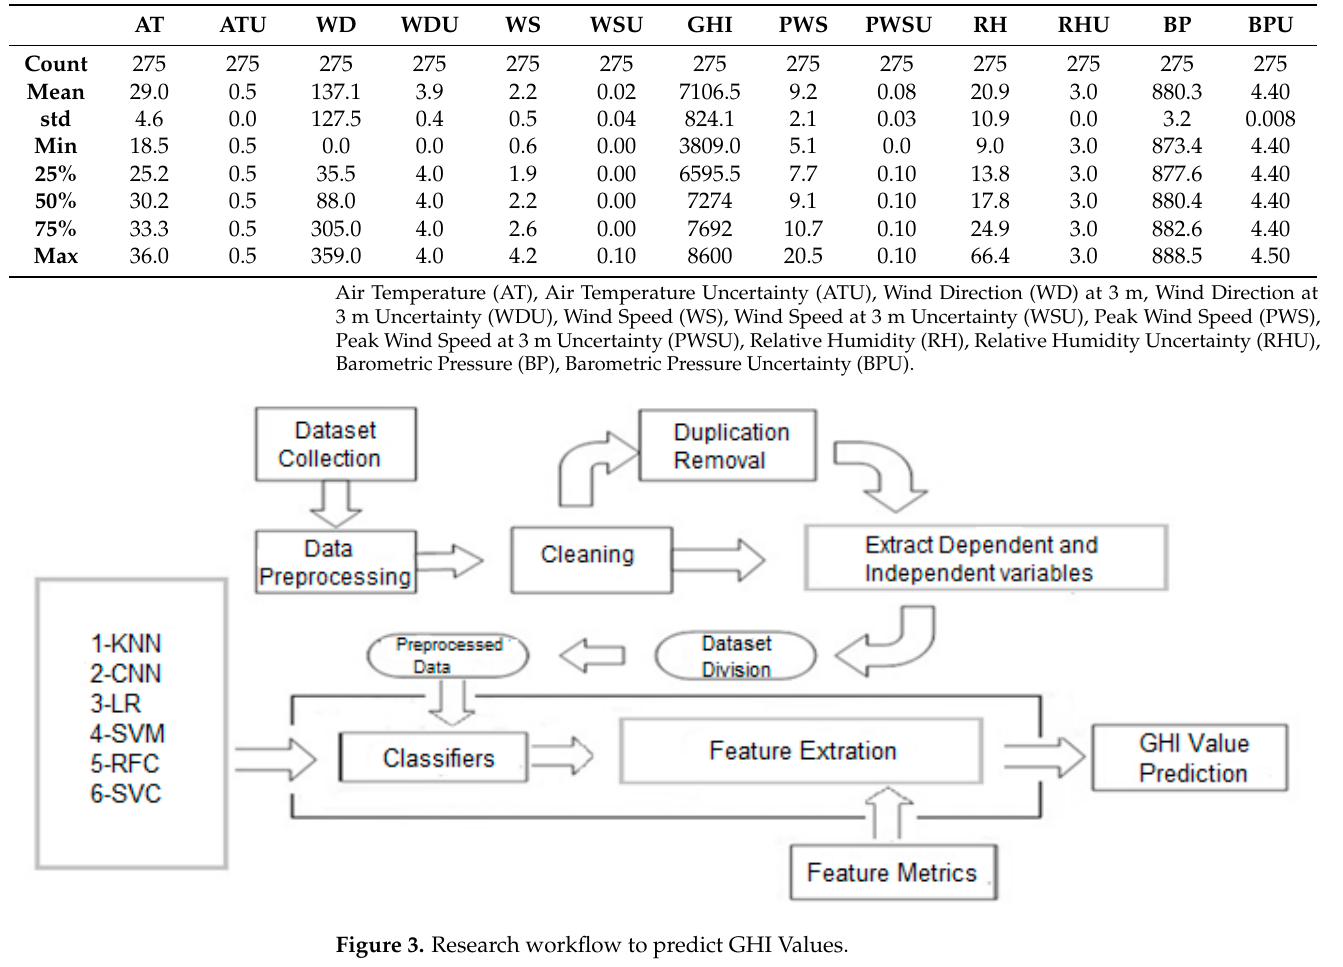
Table 2. Details of the dataset features.